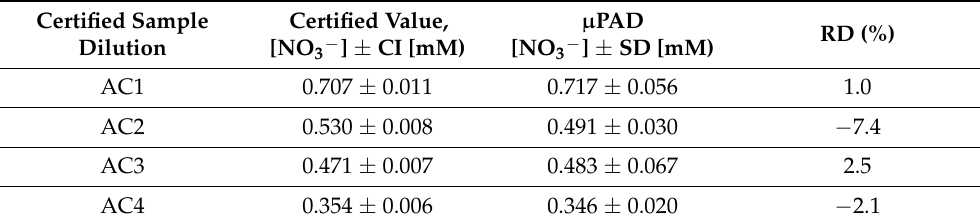
Table 3. Analysis of certified samples performed with the nitrate µ PAD; CI, confidence interval at 95%; SD, standard deviation; RD, relative